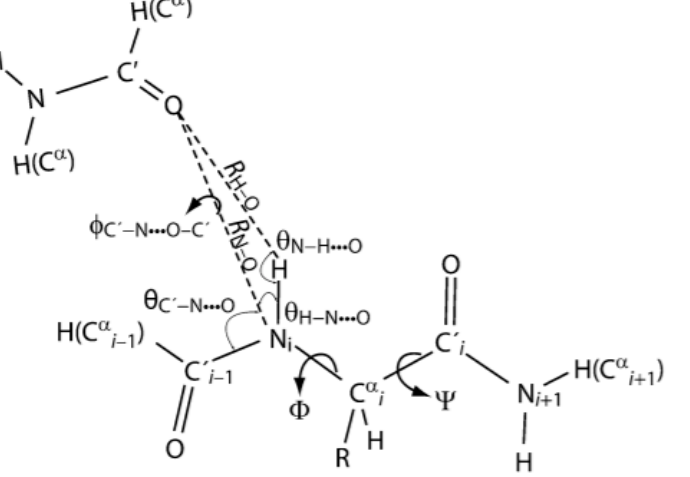
Figure 21. Angles and distances for an inter-chain hydrogen bond. Taken from [80] with permission from Springer.